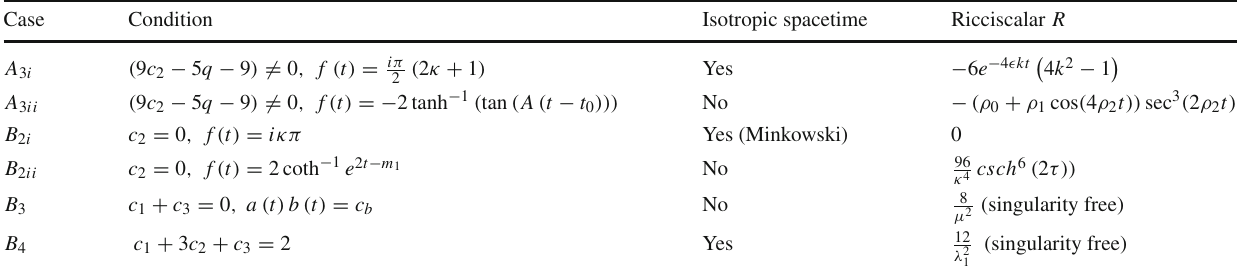
Table 1 Physically acceptable exact Bianchi V spacetimes in Einstein-aether theory Case Condition Isotropic spacetime Ricciscalar